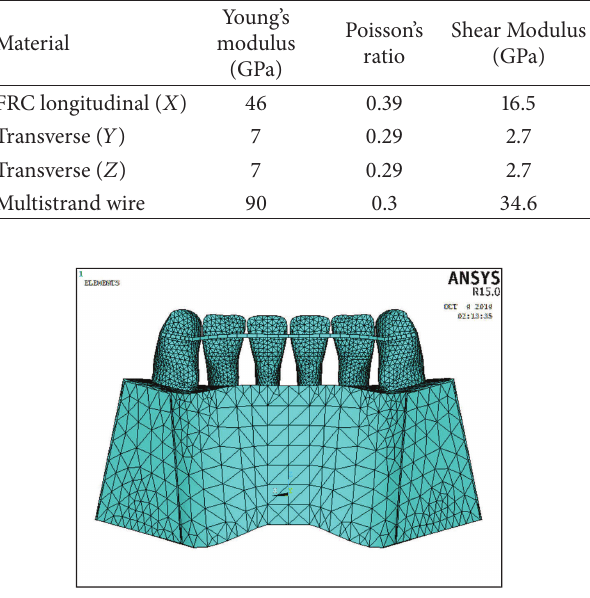
Figure 1: Model 1 in which the flexible spiral wire bonded to the lingual teeth surfaces.